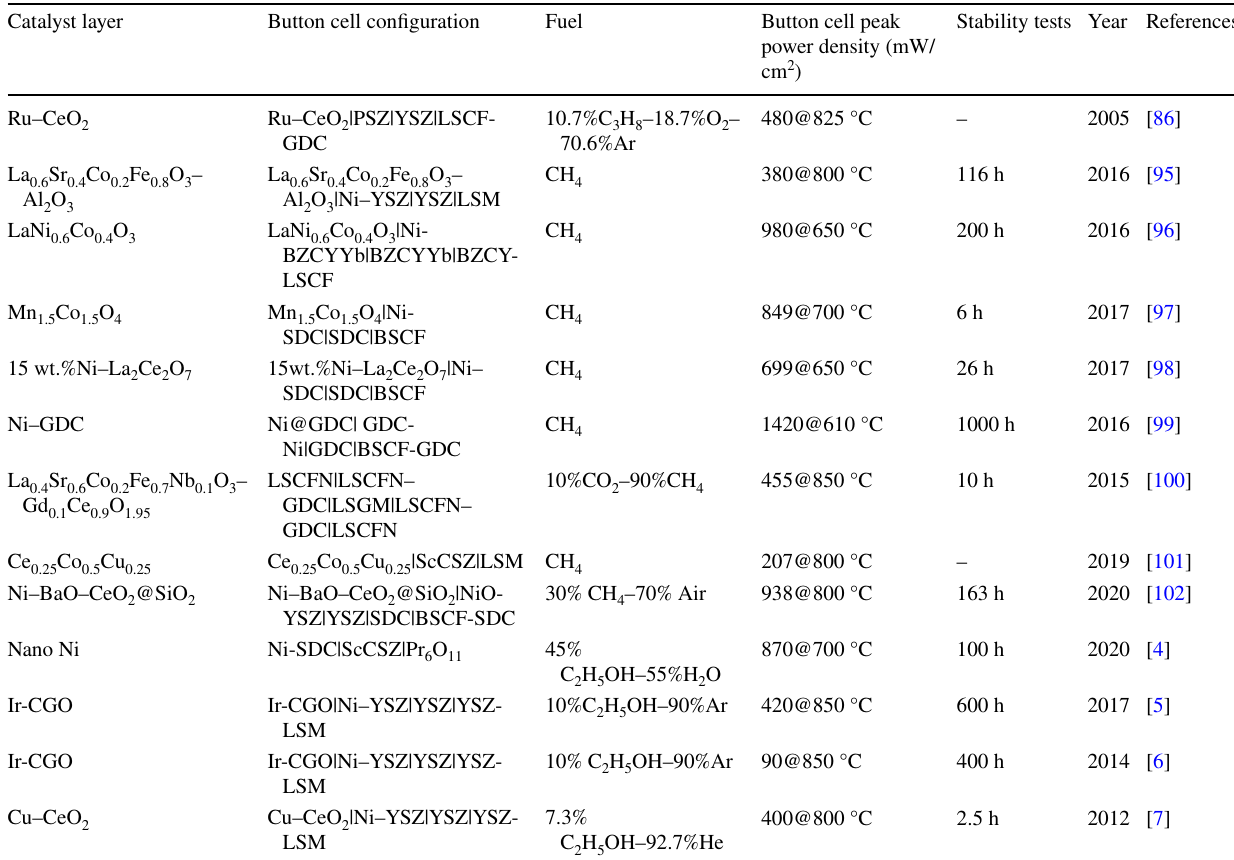
Table 6 Comparison of electrochemical performance of button cells with a catalyst